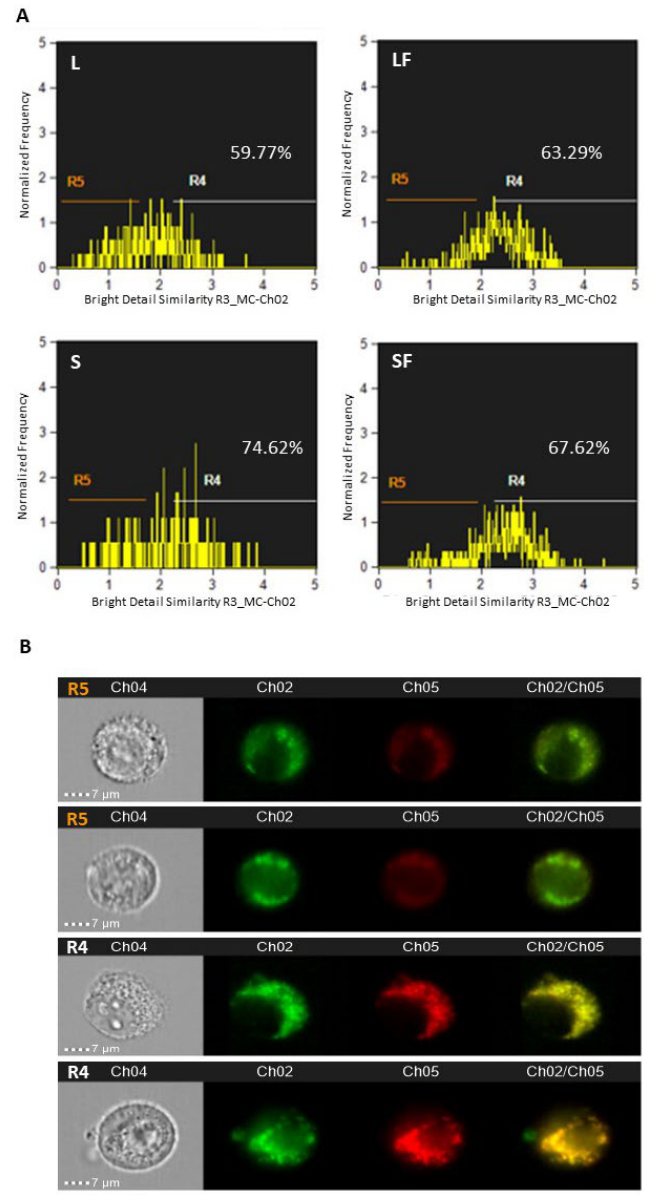
Figure 9. BBR-NPs and mitochondria co-localization in T98G cells. ( A ) Trypsinized cells were analyzed by Amnis ImageStream for bright field (Ch04), BBR (Ch02), and MitoTracker (Ch05) at 60× magnification. Percentages of co-localization signals (Ch02/Ch05) in focused cells at R4 gates are reported. ( B ) Examples of image cells of R5 (absence of co-localized signals) and R4 (presence of co-localized signals) gates are